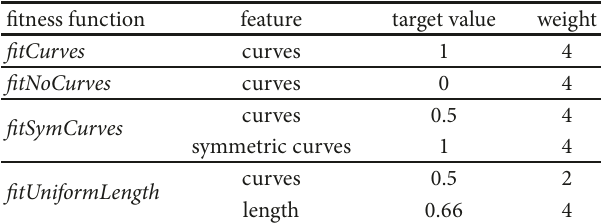
Table 5: Fitness functions designed and tested in experiment